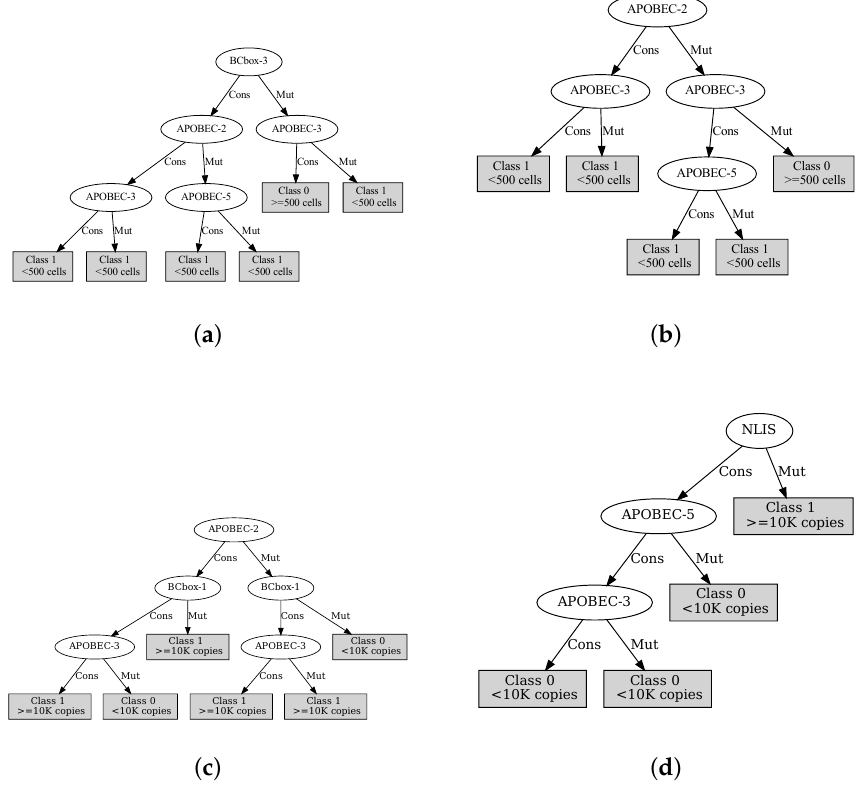
Figure 5. ID3 inducted trees using the selected most relevant variables per output as defined by the MAREV-1 approach. ( a ) The tree for CD4Ini; ( b ) The tree for CD4Hist; ( c ) The tree for VLIni; ( d ) The tree for VLHist.